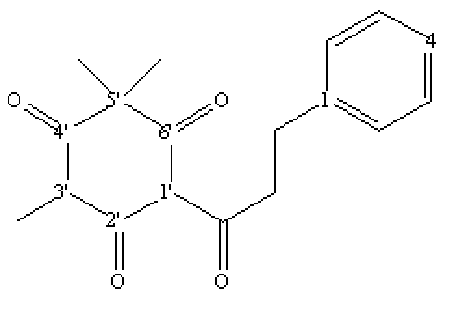
Figure 2. Chemical structure of 3-(1-oxo-3-phenylpropyl)-1,1,5-trimethylcyclohexane- 2,4,6-trione (myrigalone